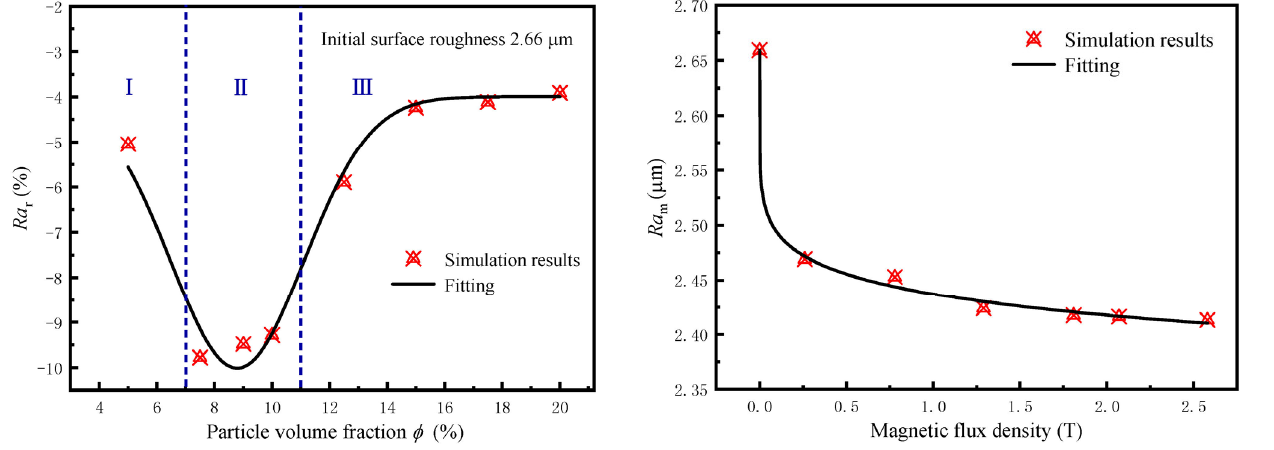
Ra with particle r